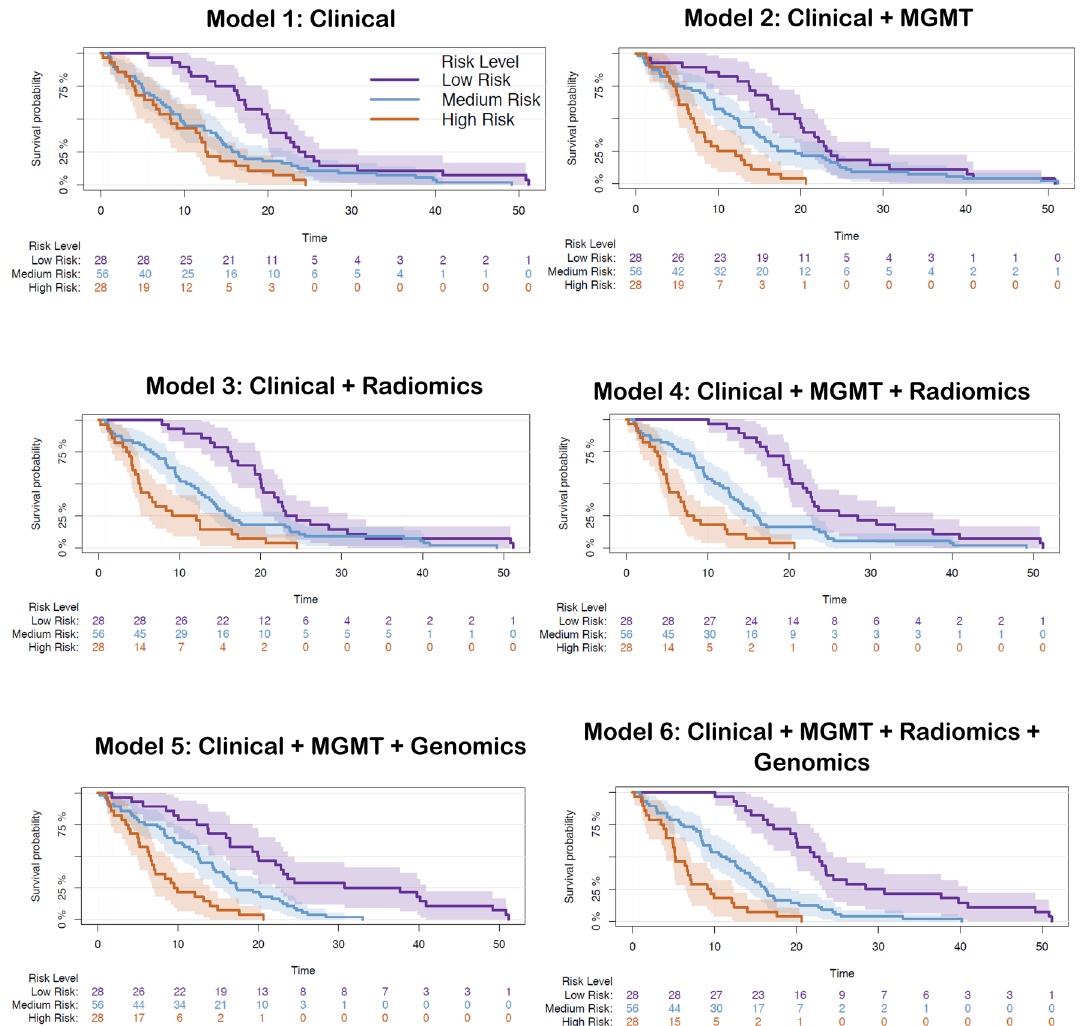
Figure 5. Risk stratification based on overall survival for the patients in our cohort (n = 112) using the six Cox-PH models including different layers of information. For illustration purposes, we have displayed low, medium, and high levels of survival probability. The survival curves are illustrated with their 95% confidence intervals. Log-rank test was performed to test for differences between the survival functions of the low, medium, and high risk groups predicted by the Cox model. The p-values obtained using this test for Model 1 (Clinical): p = 0.00016; Model 2 (Clinical + MGMT ): p = 1e−5; Model 3 (Clinical + Radiomics): p < 1e−5; Model 4 (Clinical + MGMT + Radiomics): p < 1e−5; Model 5 (Clinical + MGMT + Genomics): p < 1e−5; Model 6 (Clinical + MGMT + Genomics + Radiomics): p <